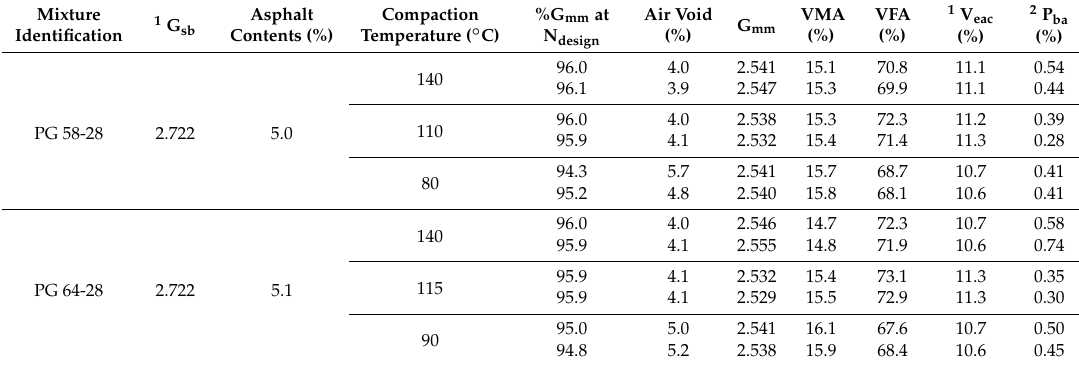
Figure 11. Relationships of aggregate orientation and energy index corresponding to volume change in the PG64-28 mixtures. Table 2. Volumetric properties of asphalt mixtures.